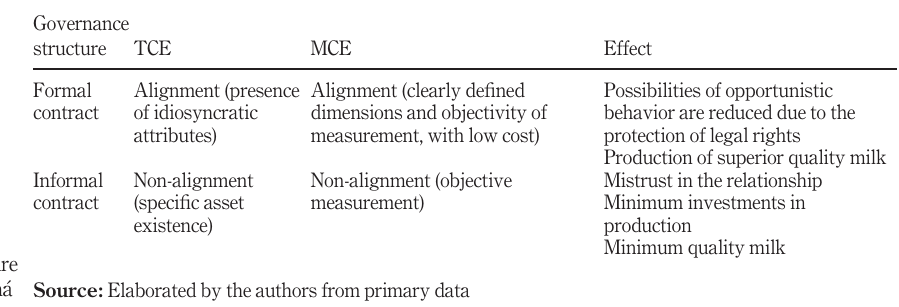
and effects in Paran (cid:1)